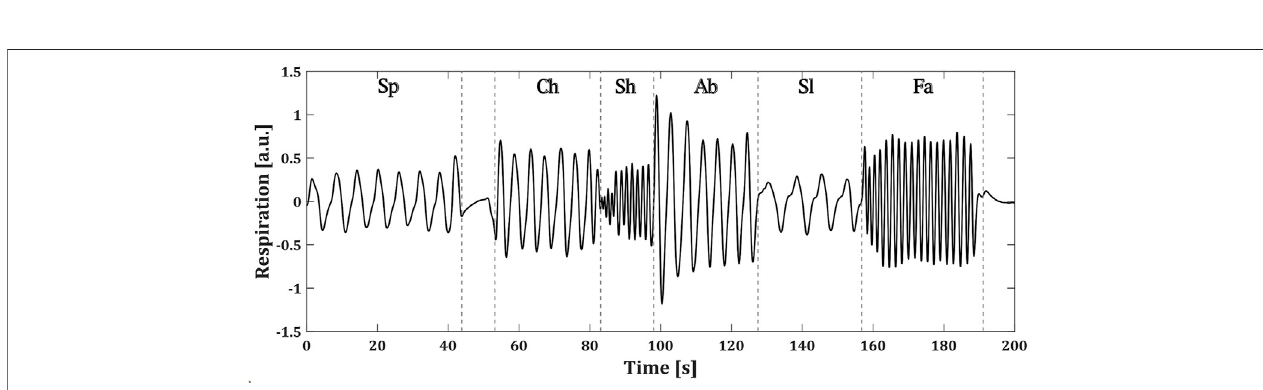
FIGURE 2 | Controlled breathing protocol followed by a BS patient. Each of the breathing types are speci fi ed as: spontaneous (Sp), chest (Ch), shallow (Sh), abdominal (Ab), slow (Sl) and fast (Fa) (a.u.) stands for arbitrary units.